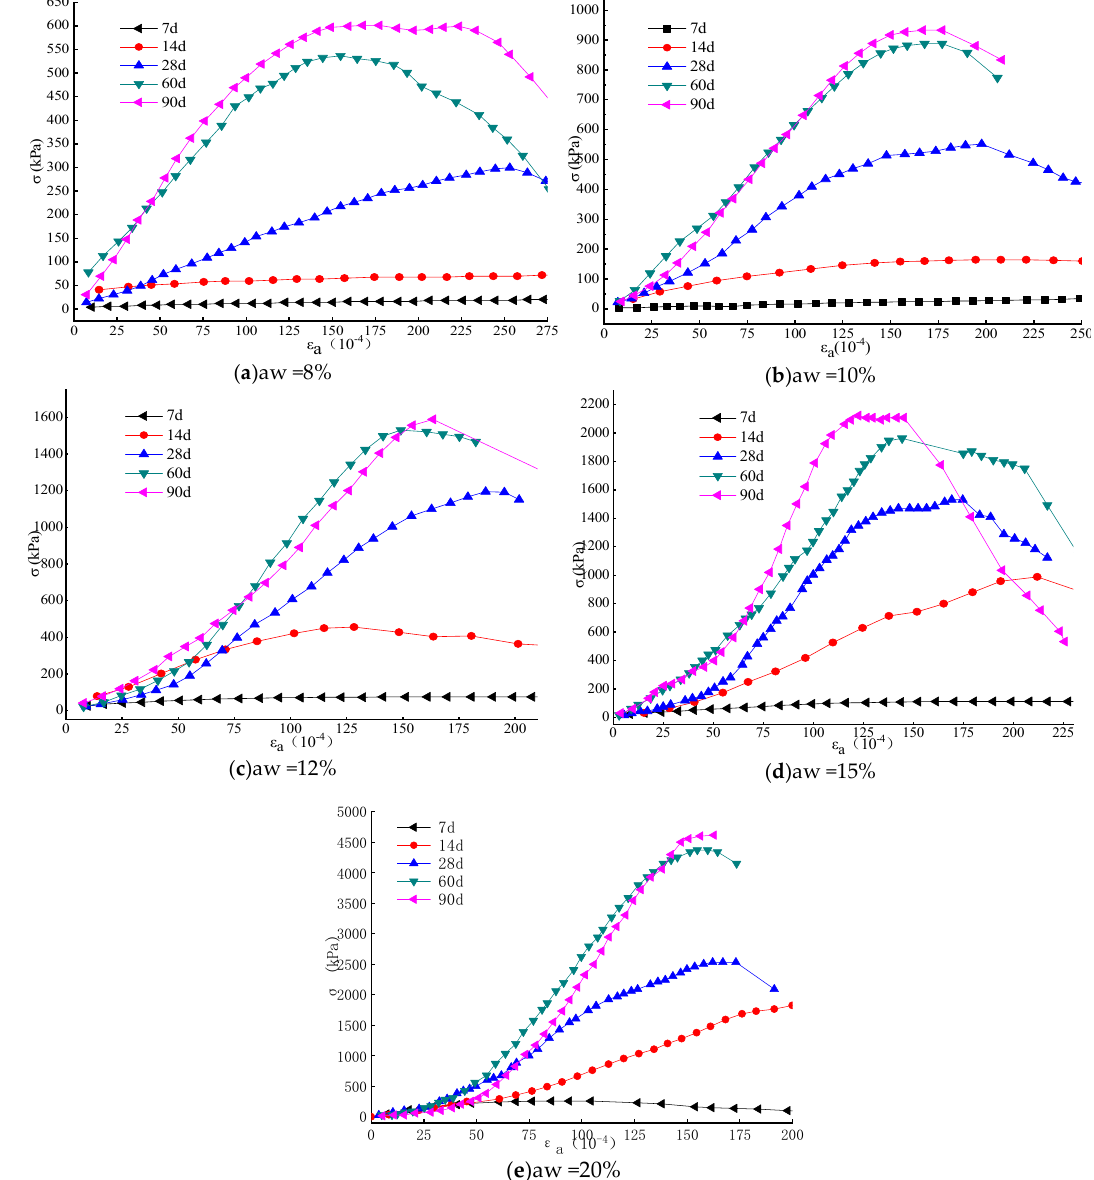
Figure 5. Stress-strain relation curves of DGSC-solidified soil under ( a ) 8%, ( b ) 10%, ( c ) 12%, ( d ) 15%, and ( e ) 20% of the content.